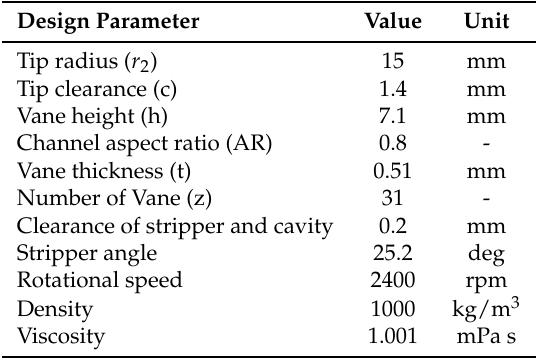
Table 3. Geometrical and fluid parameters for Yoo’s heart pump presented in [5].